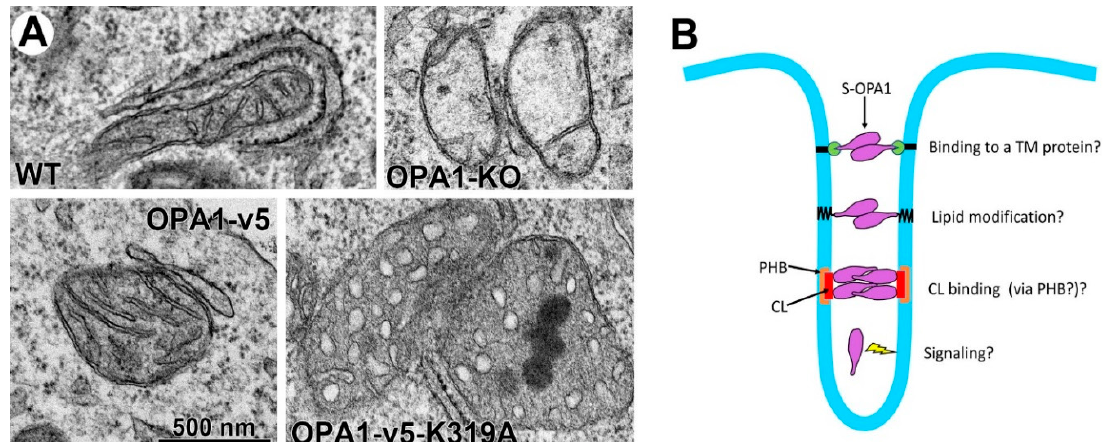
Figure 4. Cristae ballooning by a GTPase-defective OPA1 mutant and potential mechanisms of S-OPA1 for maintaining cristae tightness. ( A ) Transmission EM images of mitochondria. OPA1-KO cells have a few or no cristae. Expression of S-OPA1 (OPA1-v5) in OPA1-KO cells restores cristae structure with tight cristae width. Expression of a GTPase-defective S-OPA1 (OPA1-v5-K319A) in OPA1-KO cells restores cristae density, but not cristae tightness. ( B ) S-OPA1 may maintain cristae tightness by (1) binding to a TM-anchored protein, (2) IM-anchoring itself by lipid modification, or (3) binding to local CL that may be enriched by prohibitin (PHB). A signaling function of S-OPA1 is also possible.